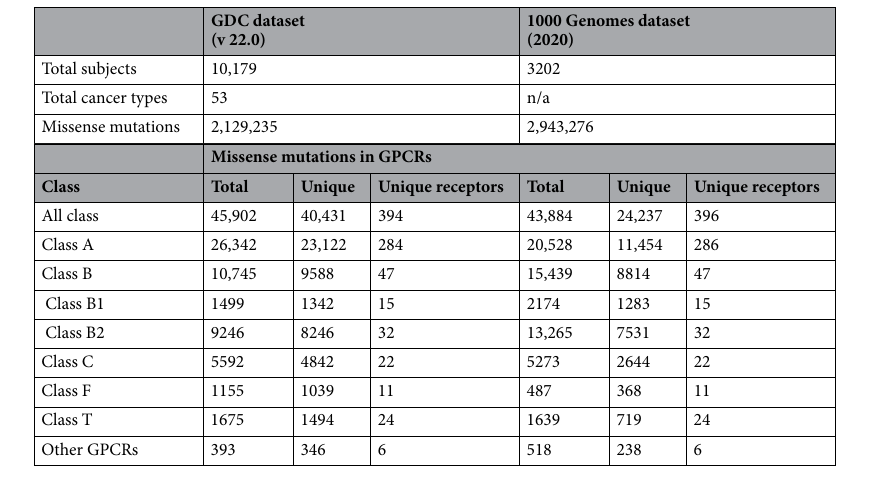
Table 1. Overview of the composition of the GDC and 1000 Genomes